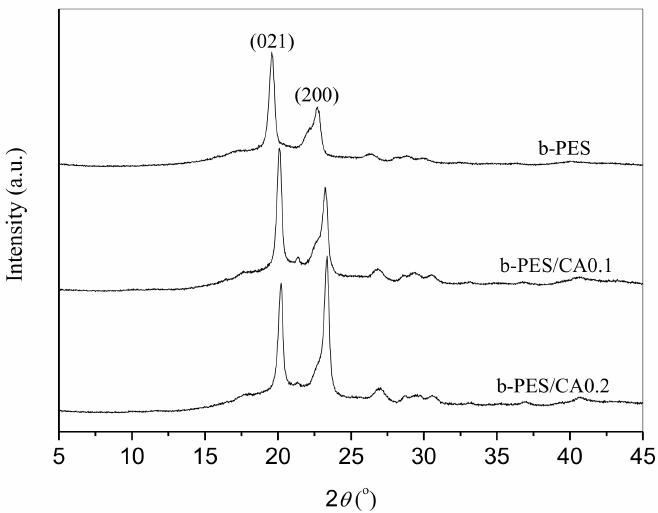
Figure 7. WAXD patterns of neat and nucleated b-PES after crystallizing at 60 ◦